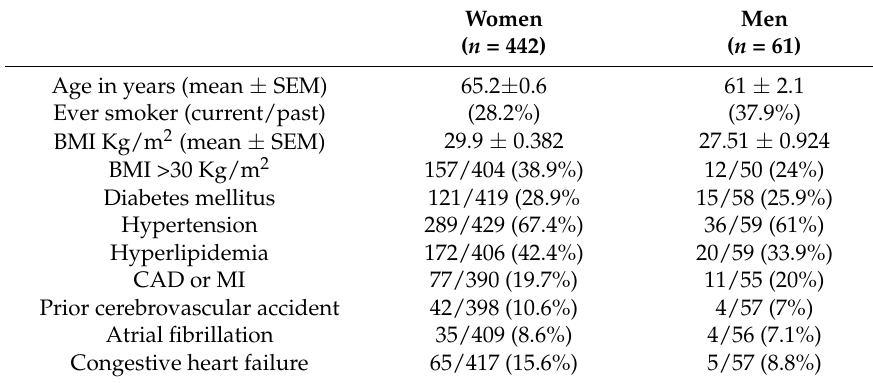
Table 2. Gender comparison.